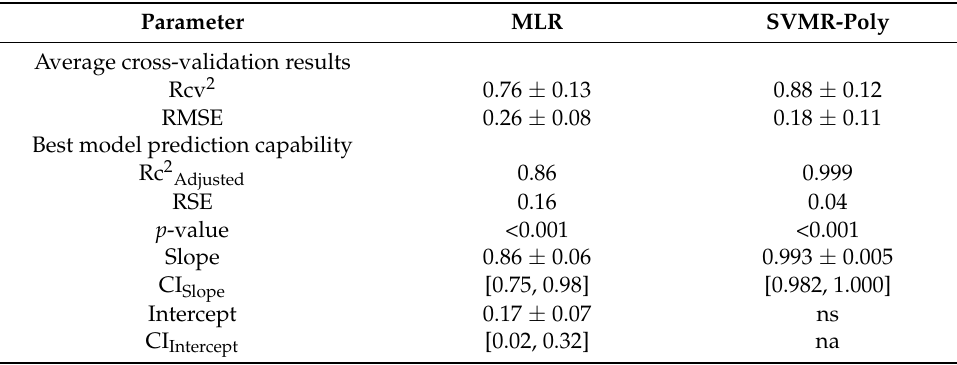
Table 3. Evaluation parameters of the MLR and SVM models.